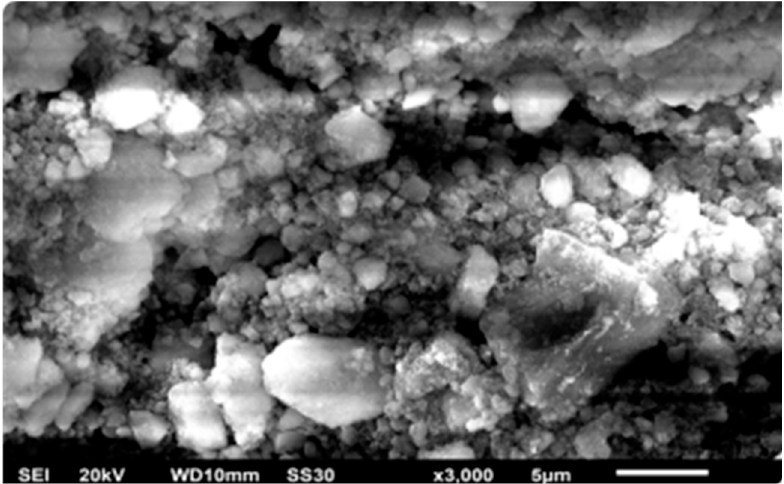
Figure 18. Surface morphology after superhydrophobic coating (modified silica with TMCS).